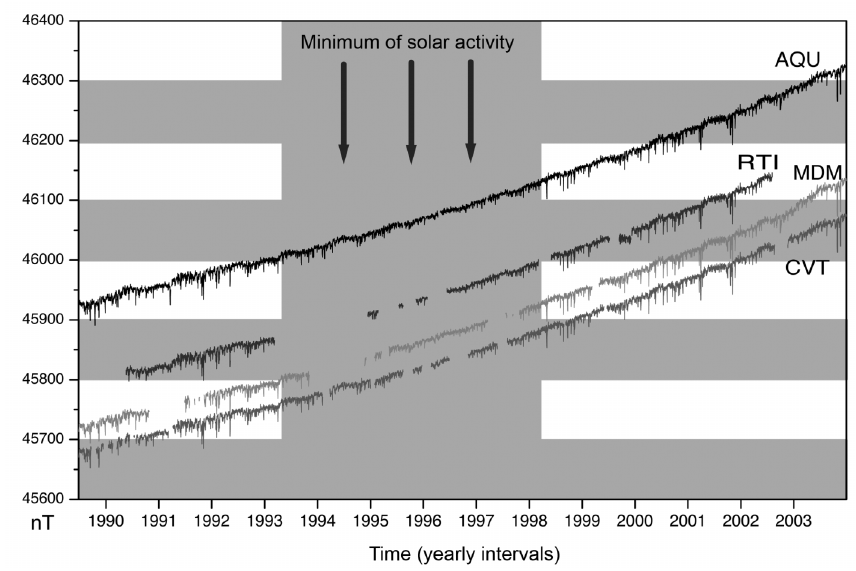
Fig. 2. Time variations of total magnetic field F (daily averages) at L’Aquila (AQU) and at tectonomagnetic stations (CVT, MDM, RTI) from July 1989 to